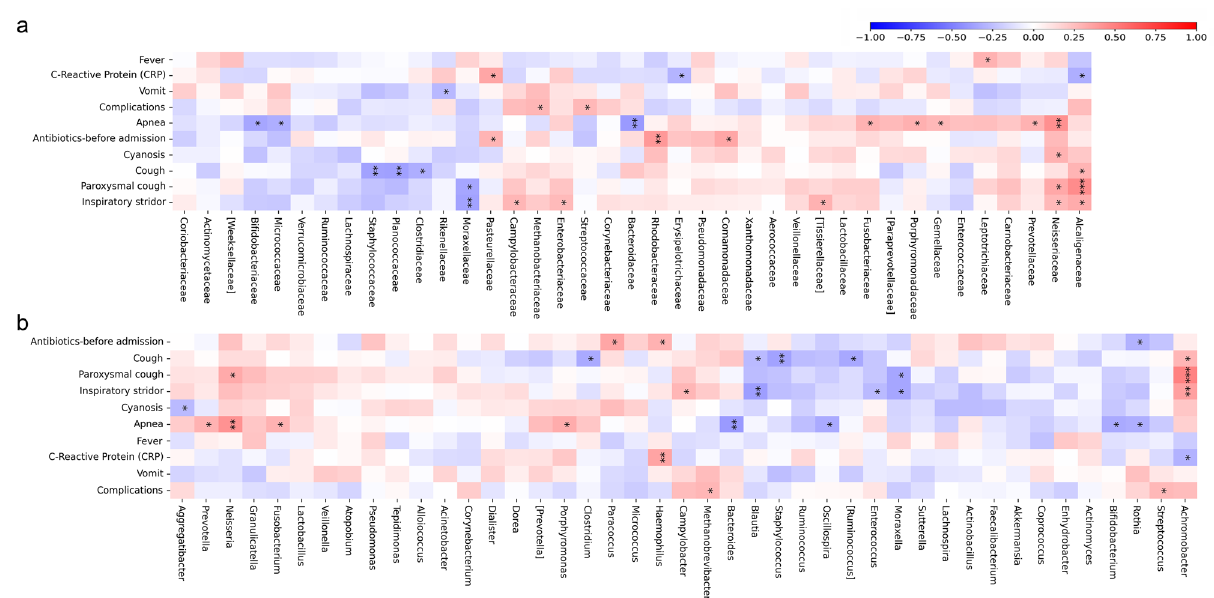
Figure 2. Pearson’s heat-map correlation. The Pearson’s correlation is calculated between clinical features and OTUs’ relative abundances at family ( a ) and genus ( b ) levels. The color scale represents the scaled level of each variable: red, positive correlation values; blue, negative correlation values. The stars indicate the statistically significant correlations ( p value ≤